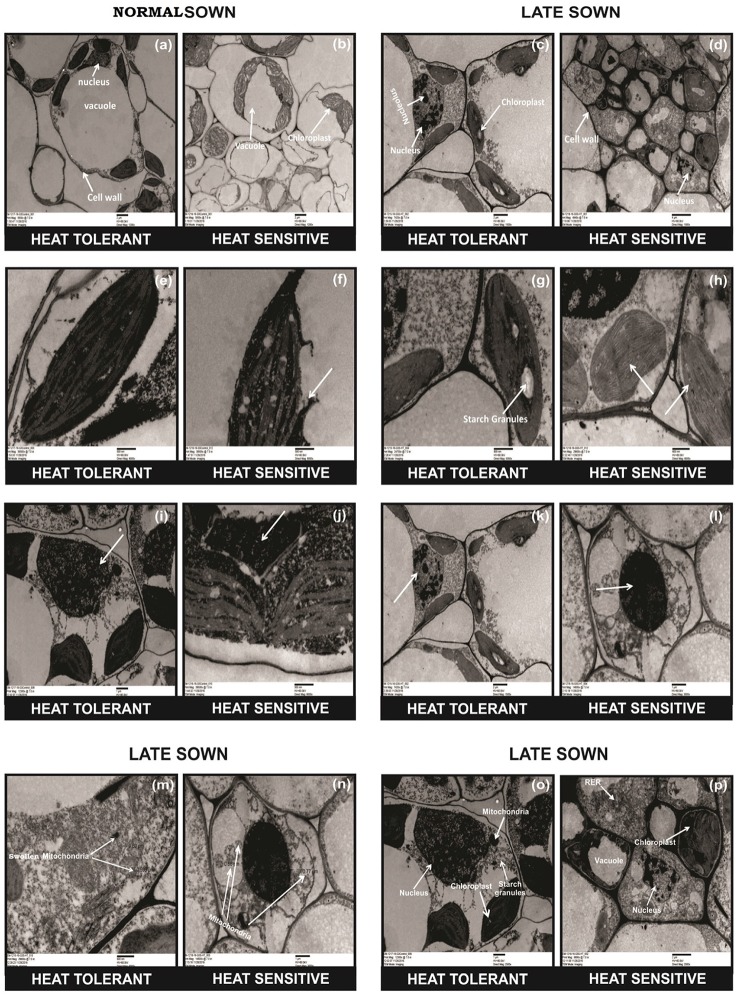
Comparative TEM observations of the ultra-structure of leaves in normal sown (NS) and late sown (LS) plants. Cell organelles from (a,b) NS and (c,d) LS plants; chloroplast from (e,f) NS and (g,h) LS plants; nucleus of (i,j) NS and (k,l) LS plants; mitochondria (m,n) from LS plants; cell wall (o,p) from LS plants. Arrows indicate (b,d) disrupted cell organelles, (p) thickened cell wall, (f,h) disrupted chloroplast, (m,n) damaged and increased number of mitochondria, (p) dispersed chromatin in nucleus, (d,p) shrinkage of vacuoles, and (d,h) fewer and smaller starch granules in the chloroplast in a heat-sensitive genotype under LS conditions.